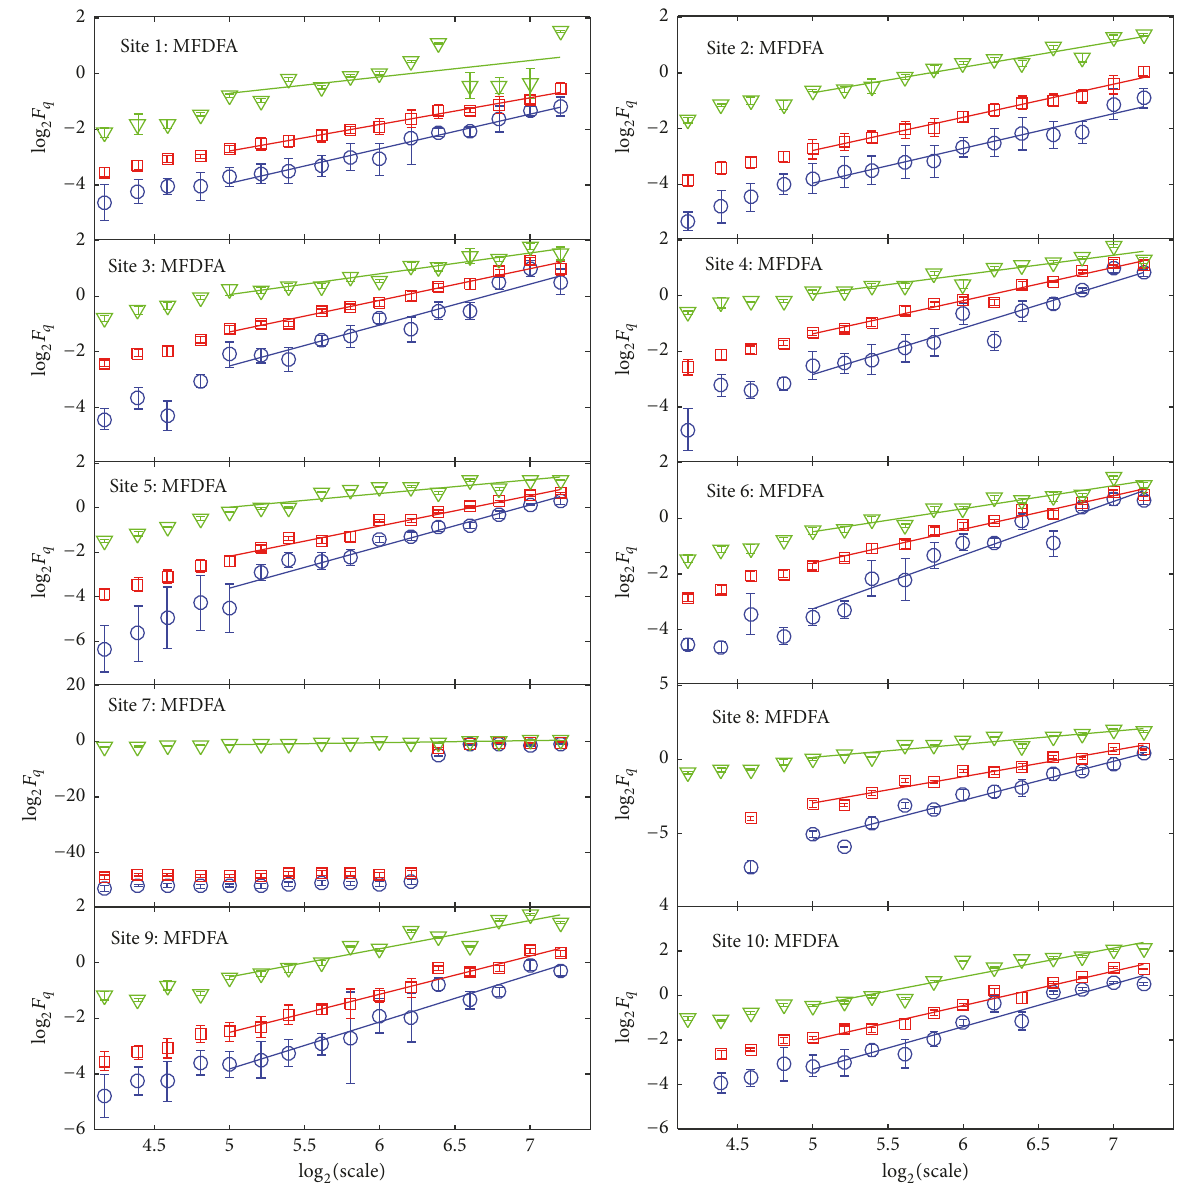
Figure 7: The log-scaling plots of the water level dynamics of all of the sites. The different symbols and colors indicate different moments: 𝑞 = −10 (blue circles), 𝑞 = −1 (red squares), and 𝑞 = 10 (green triangles). The colored lines indicate the regression lines of the corresponding colors from scale 2 5 to scale 2 7.2 . These results correspond to an averaging over 100 sets of daily records. The errors bars are obtained from these sets and reveal 95% confidence interval. Some abnormal points at small scales are not shown in the figure because of their very small values such as points of scale 2 4.4 and scale 2 4.8 at Site